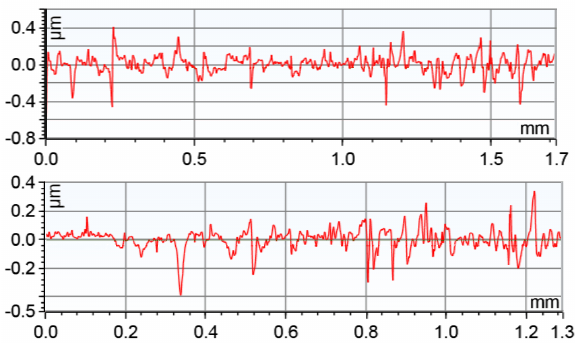
Figure 1. Surface profile of ZrN coating across direc- tions: a) horizontal; b) vertical.